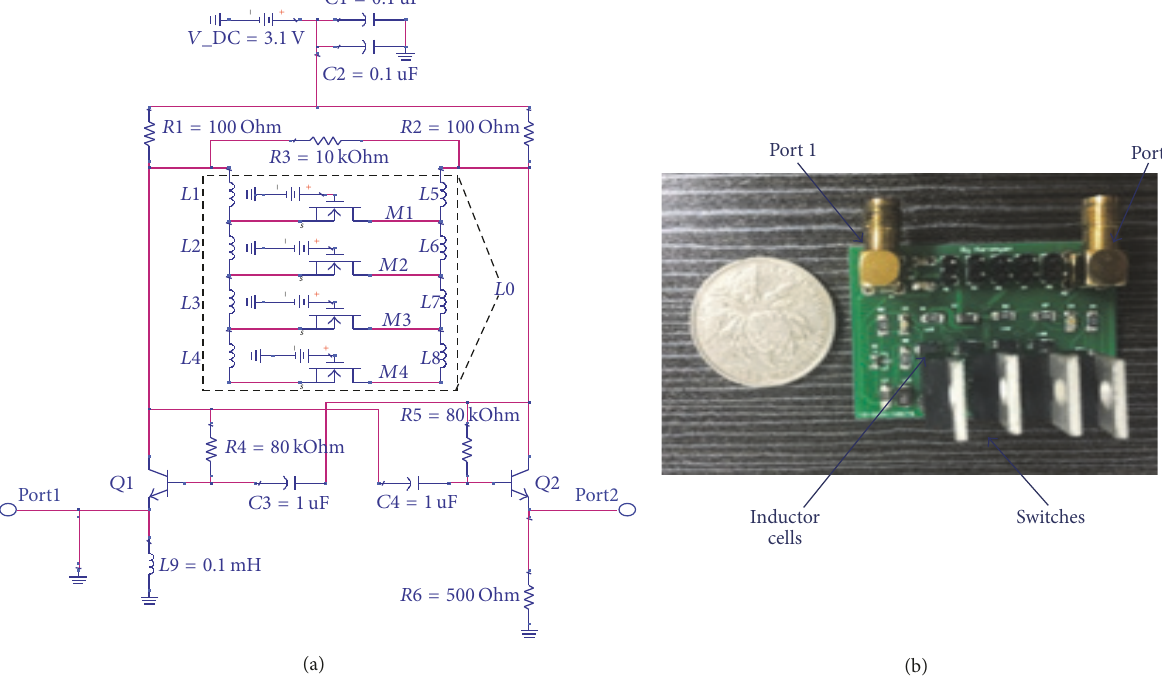
Figure 5: (a) Floating two-port “tunable-negative-inductive” NFC for VLF receive antenna. (b) Photograph of the NFC applied in VLF (45 mm length, 35 mm width).